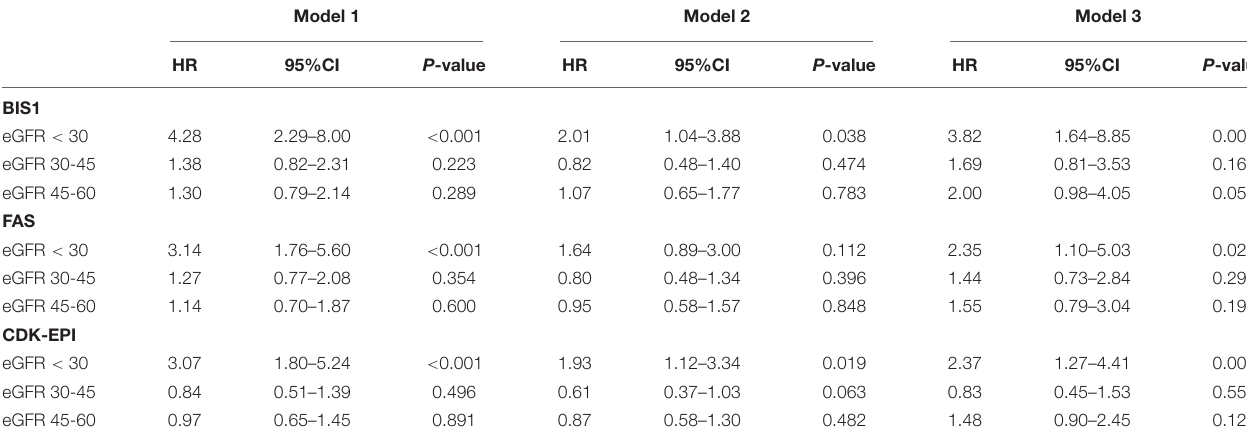
TABLE 2 | The hazard ratio for the relationship between eGFR and survival chance during the follow-up time. Model 1 Model 2